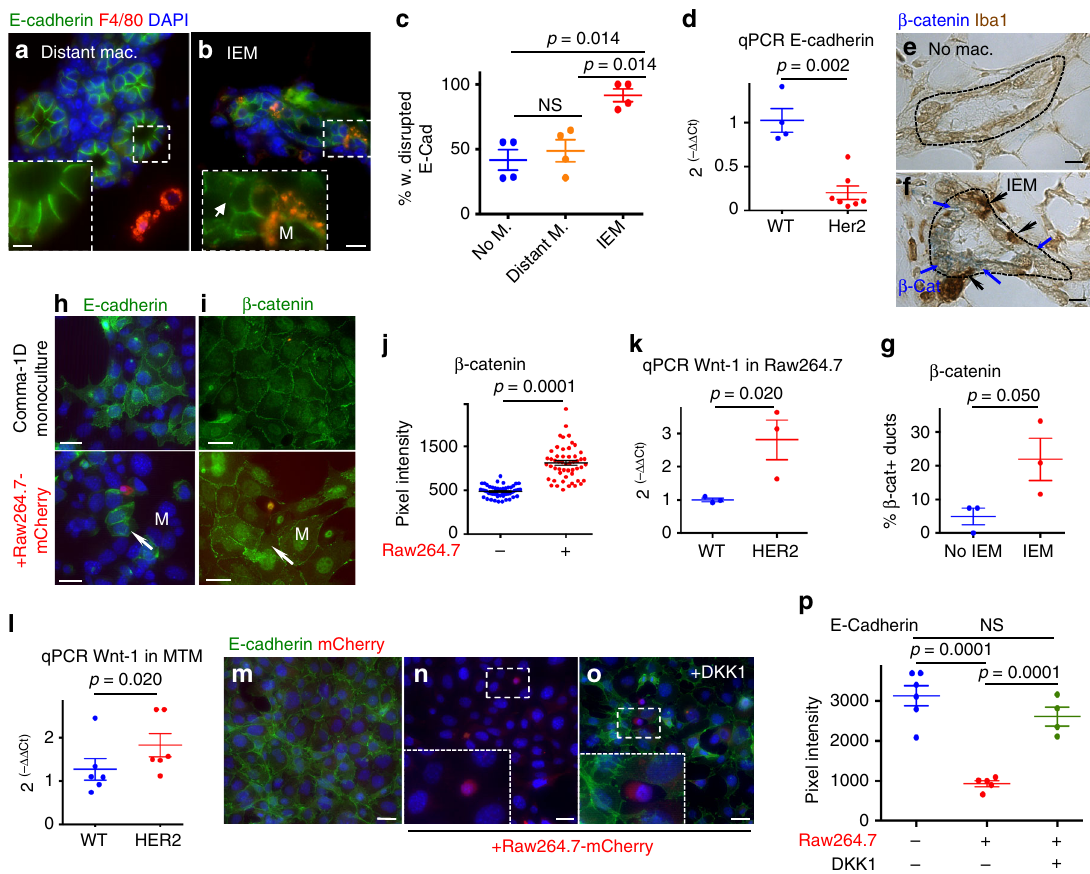
Fig. 2 Intra-epithelial macrophages (IEMs) induce an EMT-like response in early cancer cells. Twenty-week-old MMTV-HER2 mouse mammary glands were stained against E-cadherin and F4/80. E-cadherin localization was analyzed dependent on whether macrophages did not make direct contact to the duct (no M. or distant M.; a ) or whether ducts contain IEMs ( b ). The percentage of individual epithelial cells with disrupted E-cadherin was quanti fi ed